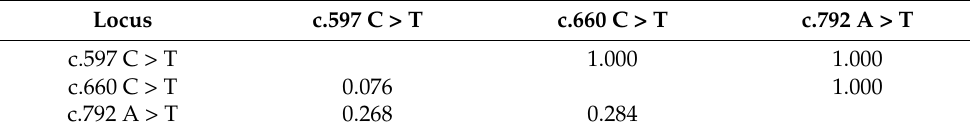
Table 4. Linkage disequilibrium analysis of four SNP loci of the Mm-Smad3 gene.